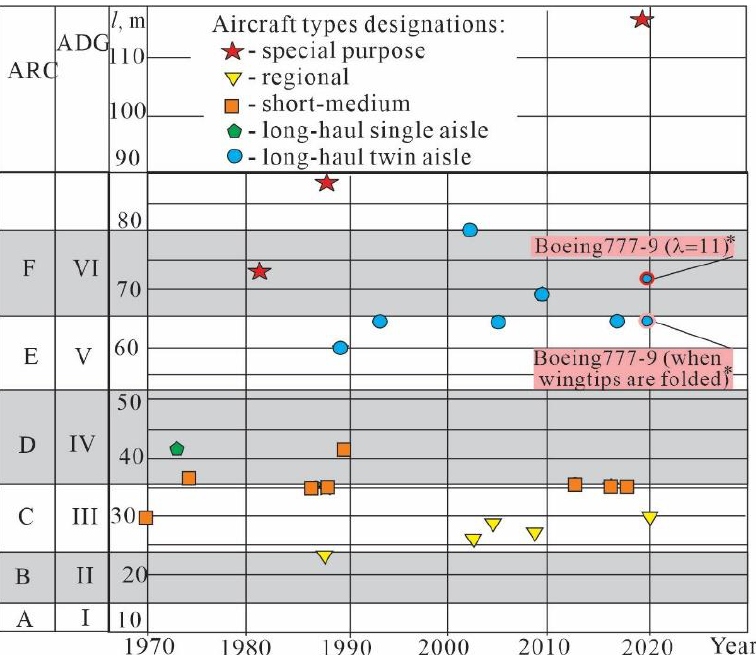
Figure 3. Evolutionary aircraft wingspans and categories of airports and aircraft [23]. * For the Boeing 777X aircraft, two wingspans are shown: “ground” and “flight”.